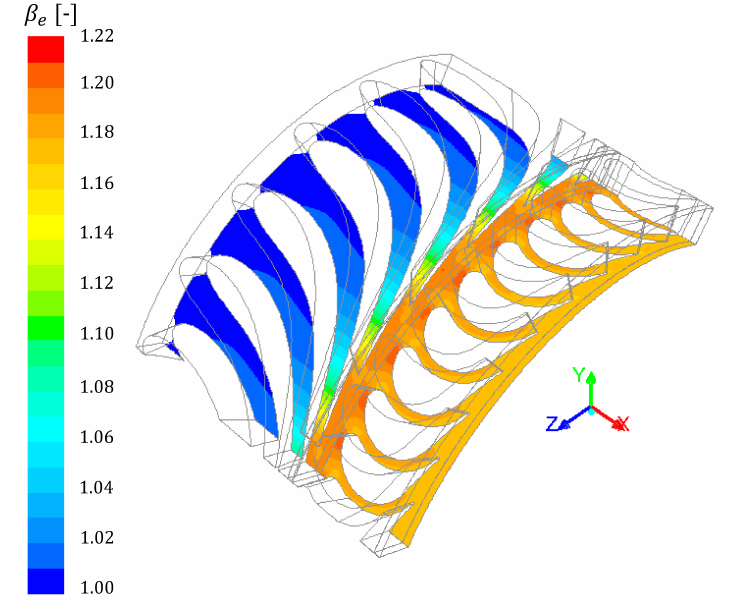
Figure 12. Contours of expansion ratio at the hub of stator and rotor blade